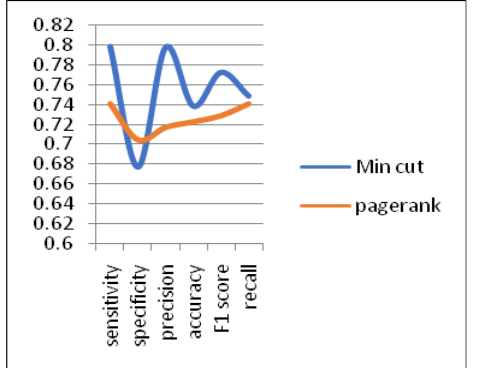
Fig. 4. Various analysis for Min-Cut